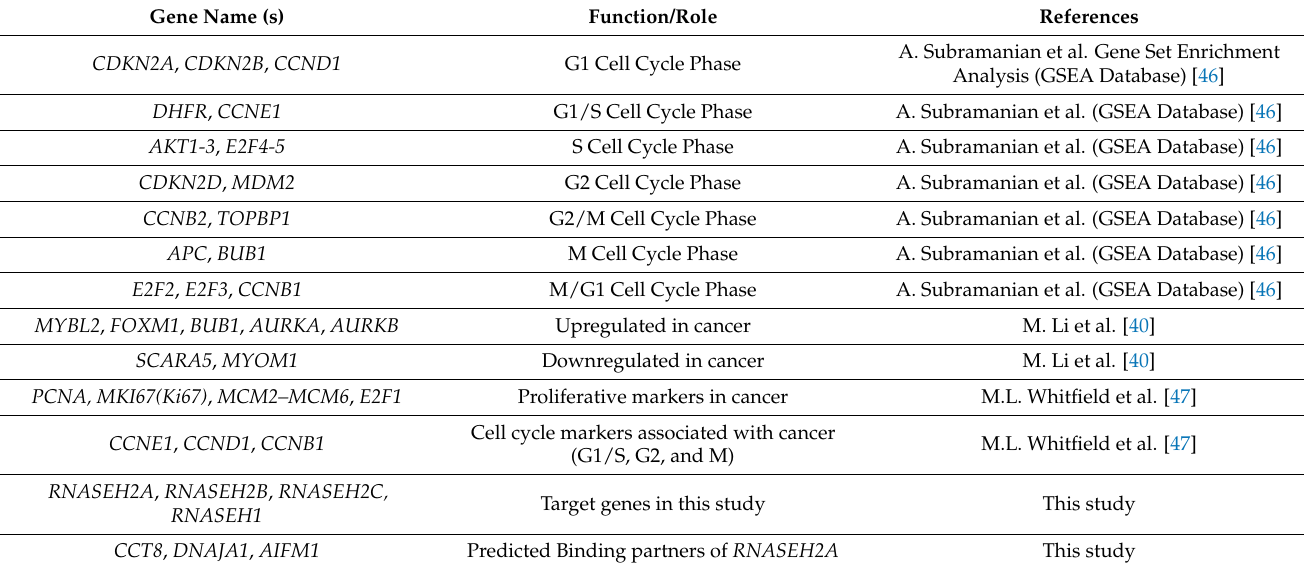
Table 5. List of genes related to cancer proliferation and cell cycle phases used for correlation analysis in Cancer Cell Line Encyclopedia (CCLE) and TCGA Pan Cancer